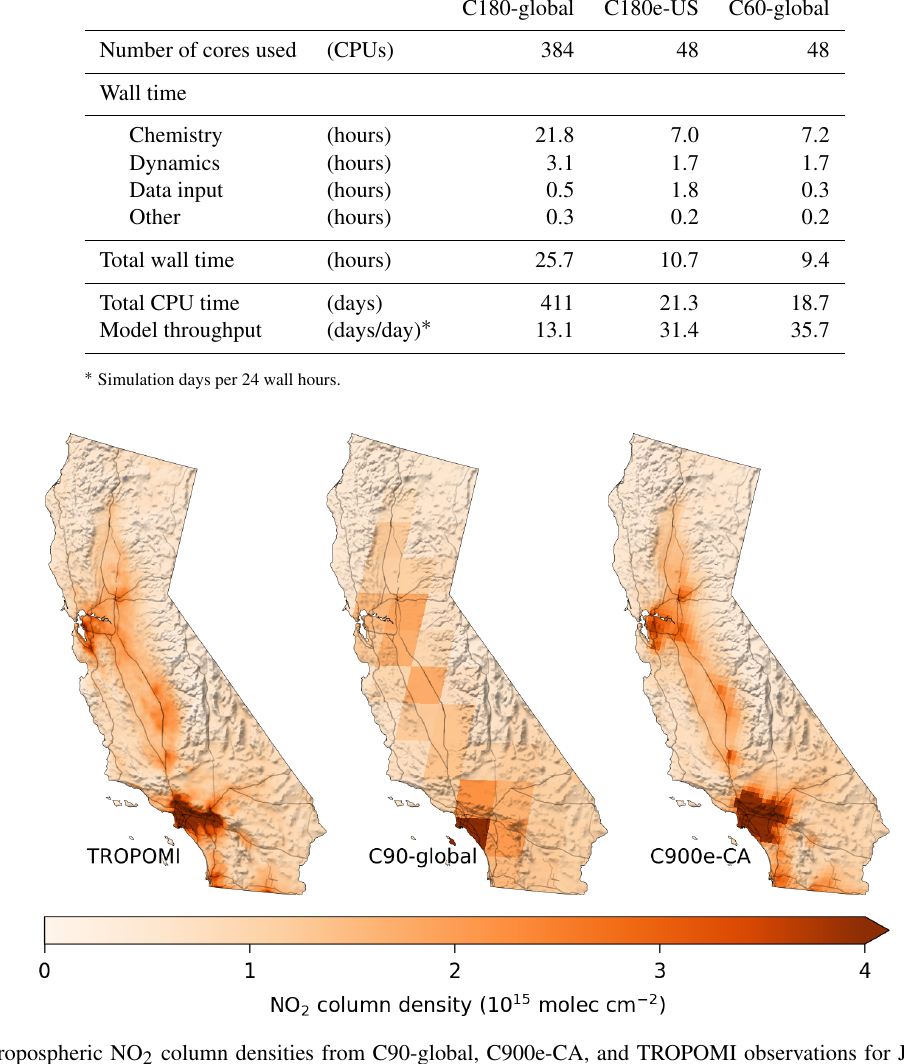
Figure 9. Mean tropospheric NO 2 column densities from C90-global, C900e-CA, and TROPOMI observations for July 2019. Simulated means only include points where TROPOMI observations were available. TROPOMI columns shown here use shape factors from C900e-CA. An annotated map of California is provided in Fig.